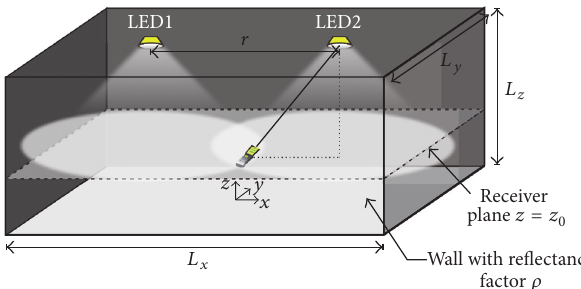
Figure 1: An indoor VLC system model with two LEDs tiled in the ceiling of a room dimension of 𝐿 𝑥 × 𝐿 𝑦 × 𝐿 𝑧 (length, width, height).